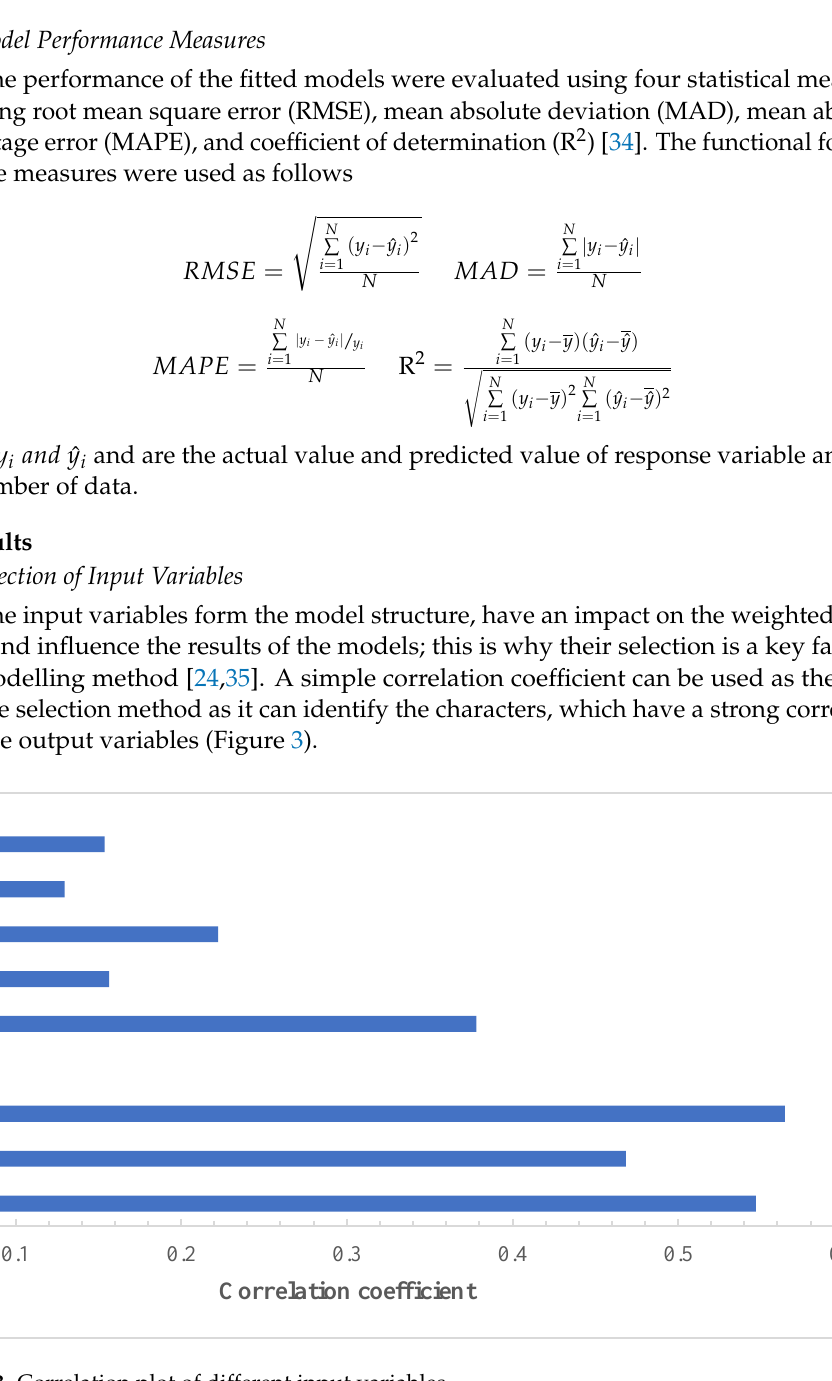
Figure 3. Correlation plot of different input